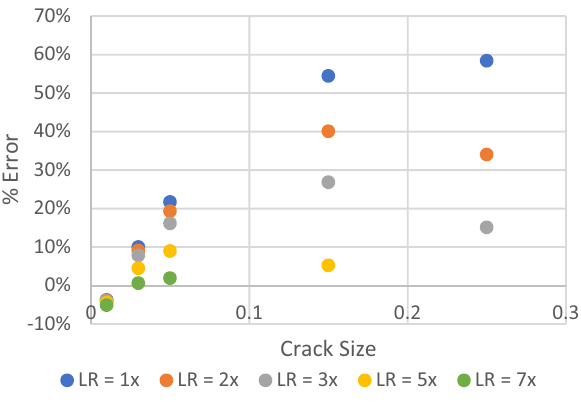
Fig. 9 Error in stress intensity factors for plate with hole diameter 0.25 the plate width